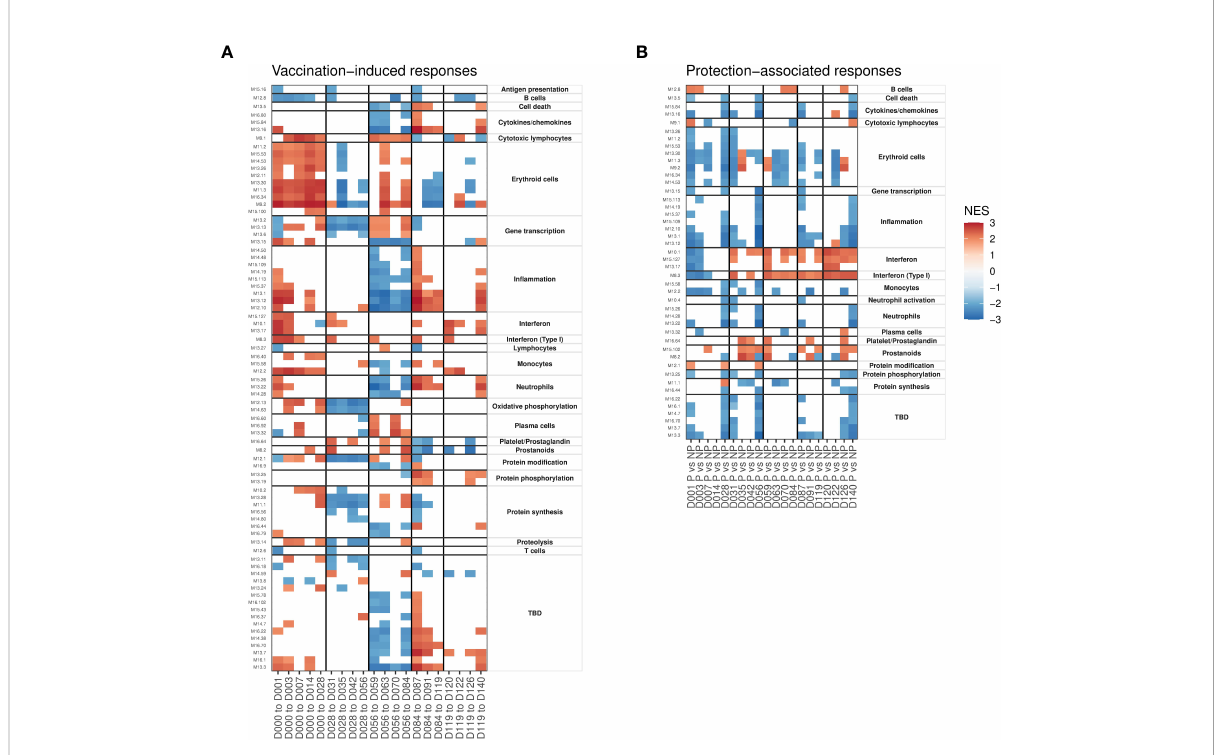
FIGURE 3 Gene set enrichment analyses showing patterns of vaccine-induced and protection-associated responses pro fi led using blood transcription modules (BTMs). Heatmaps show signi fi cant (FDR < 0.05) normalized enrichment scores (NES). (A) BTMs signi fi cantly enriched for genes changing in expression relative to day of the most recent immunization. (B) BTMs signi fi cantly enriched for genes with expression differences between protected and non-protected individuals at each timepoint. Vertical black lines indicate times of immunizations in both